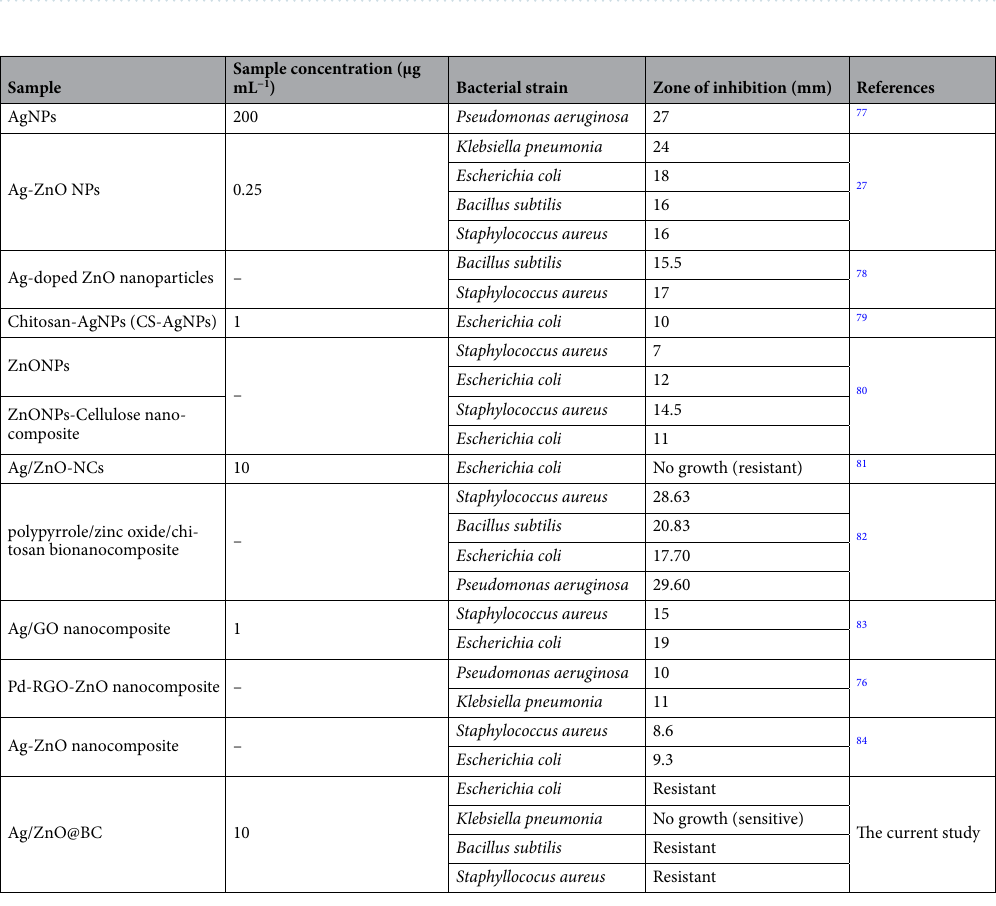
Table 1. Comparison between the antibacterial efficiency of Ag/ZnO@BC prepared in the current study and other AgNPs, ZnONPs, and nanocomposite prepared in other studies.